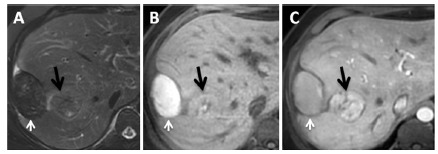
MRI in a patient with adenoma with bleeding: A) a T2 sequence with fat saturation shows a hepatic subcapsular nodule with hyposignal; B) a pre-contrast T1 sequence reveals a lesion with hypersignal, indicating products of hemoglobin degradation; C) a post-contrast T1 sequence in the arterial phase emphasizes the intra-hepatic lesion where the black arrow points to the lesion and the white arrow to the hematoma.